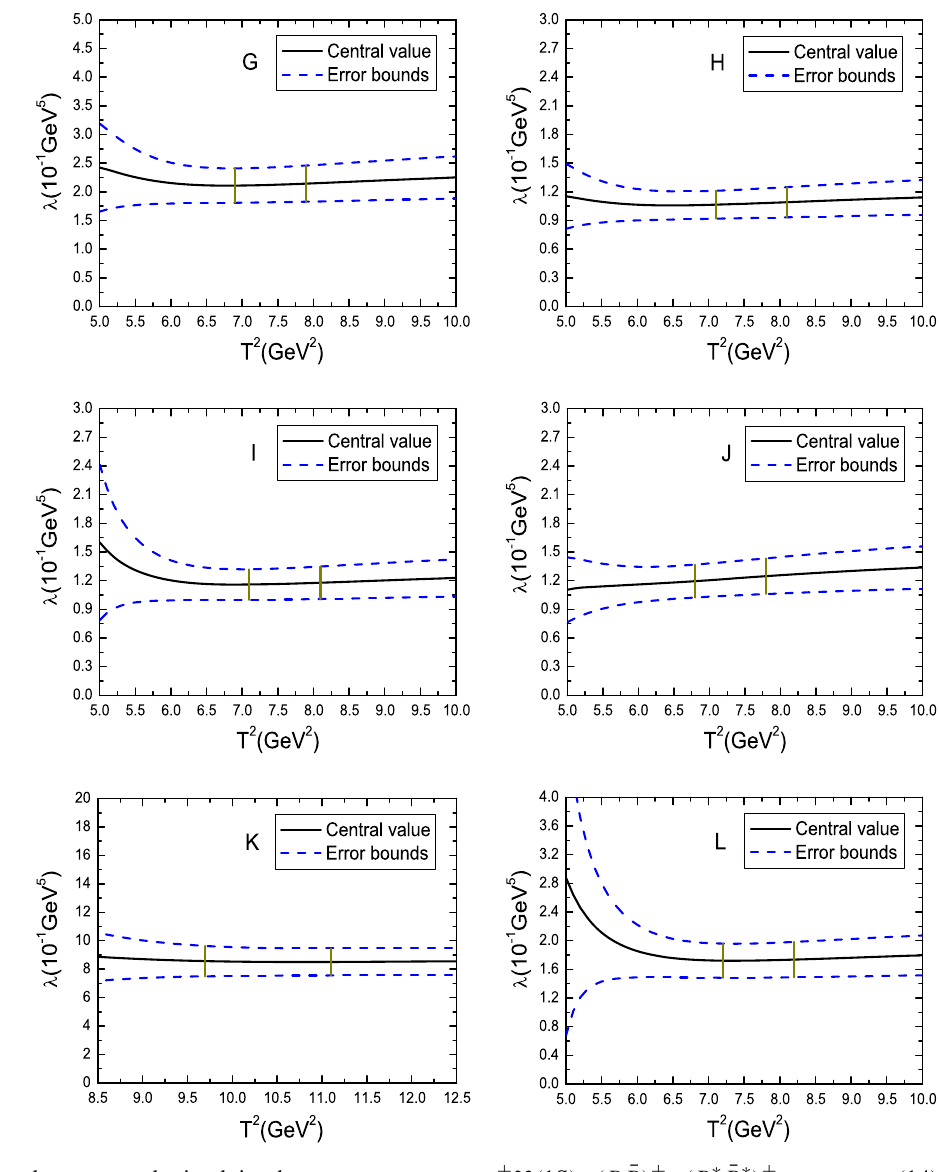
Fig. 4 The pole residues with variations of the Borel parameters T 2 for the hidden-bottom tetraquark states, the G , H , I , J , K and L denote the tetraquark states [ ub ] (cid:6) [ db ] − [ ub ] [ db ] (cid:6) A A A